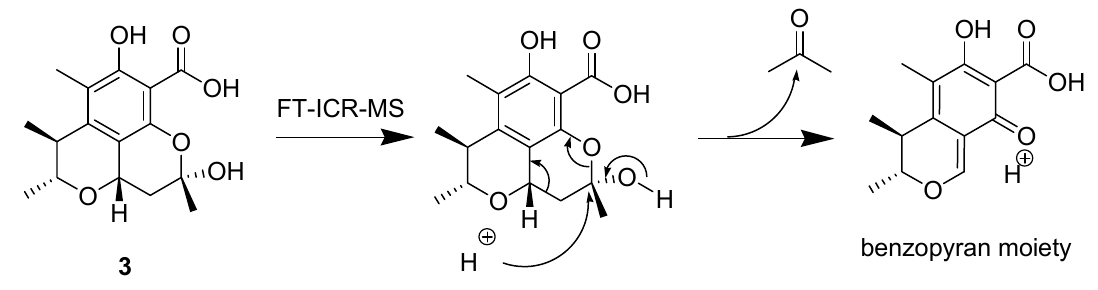
Figure 4. The benzopyran moiety of compound 3 .